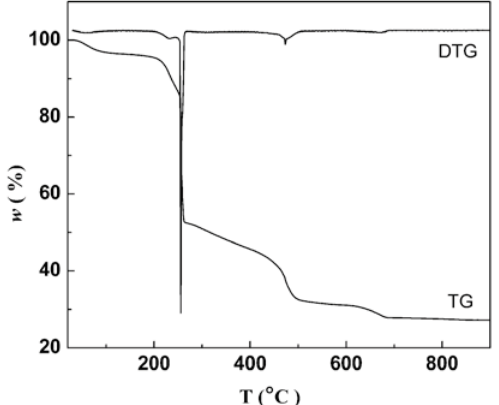
Figure 1. TG-DTG curves of [La(HL)(H